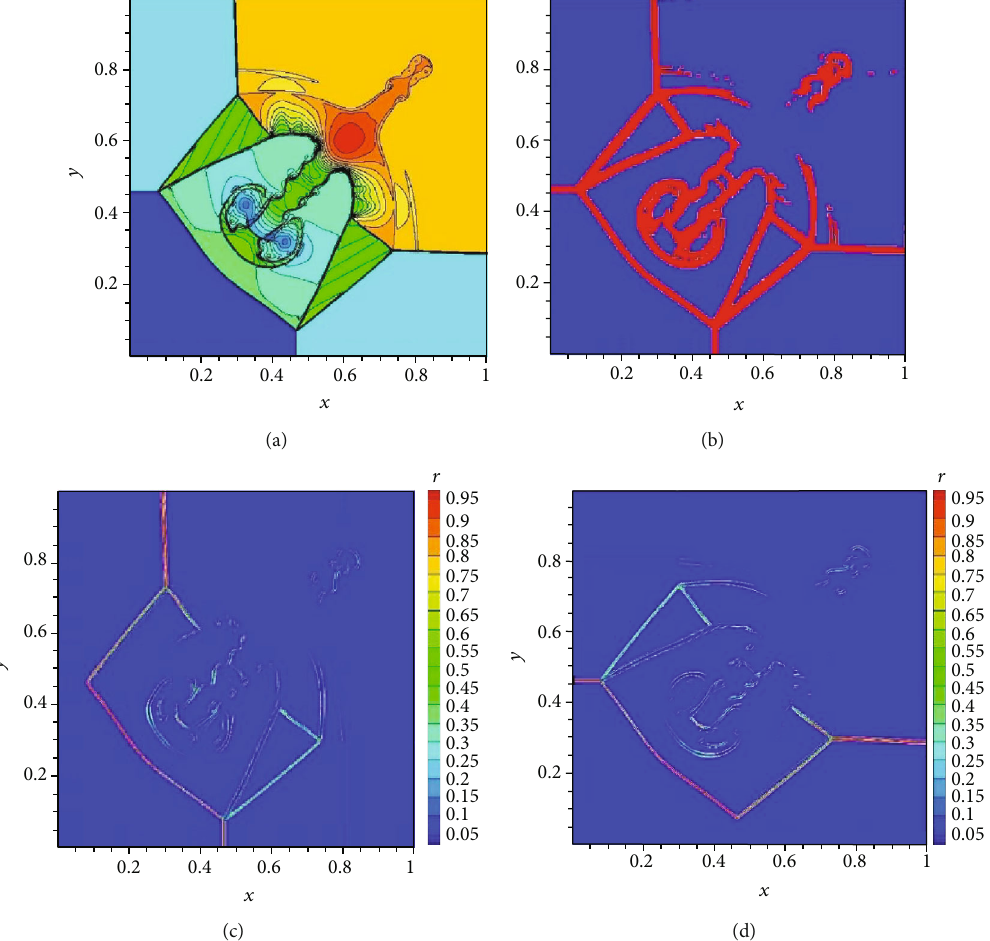
Figure 13: Results calculated by the hybrid WCNS-CPR scheme. NI = 0 : 1 . DOFs = 960 × 960 . (a) Density from 0.13 to 1.78 with 25 contours. (b) Distribution of di ff erent cells: red represents WCNS, blue represents CPR. (c) NI in the x direction. (d) NI in the y direction.